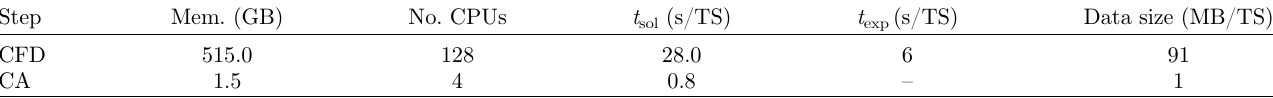
Table 5. Overview of computational resources required for the steps in the simulation work fl ow.